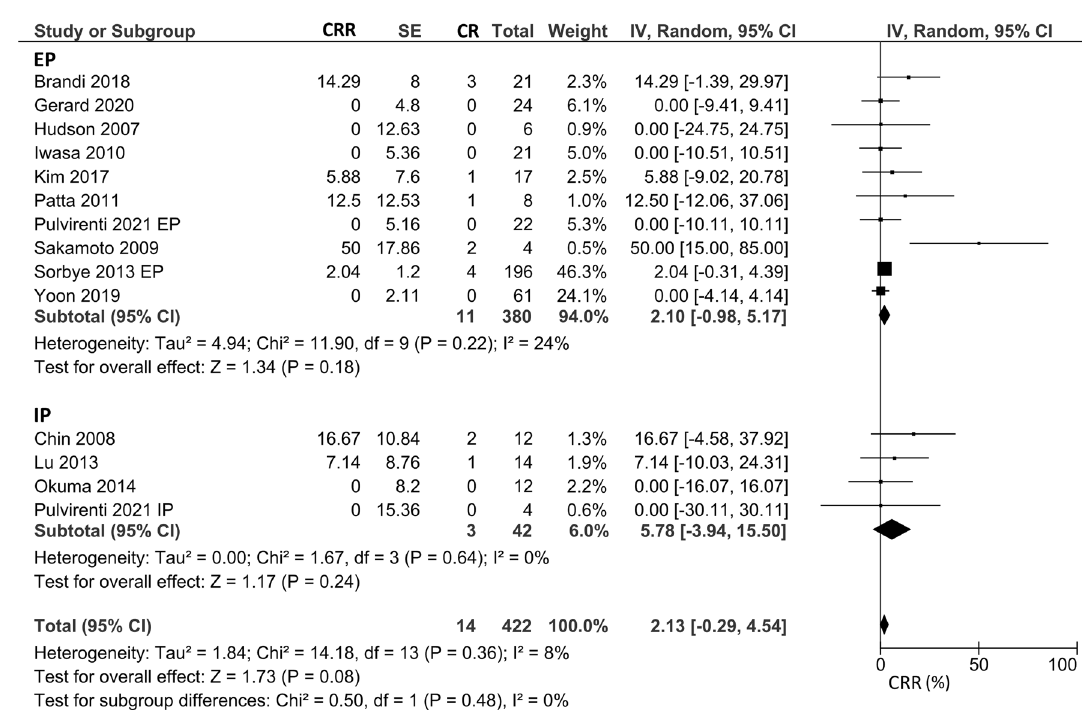
Fig. 4 Pooled CRR in patients treated with platinum-doublet chemotherapy. 10 studies that evaluated patients treated with EP and four studies that evaluated patients treated with IP were included in this analysis. CRR complete response rate, EP platinum plus etoposide, IP platinum plus irinotecan